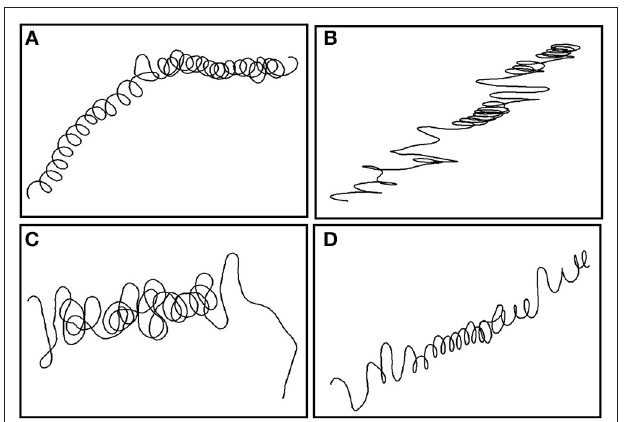
FIGURE 5 | Fifteen minute pseudo-tracks of looping behavior from each sandbar individual around dusk. (A) Shark 1 at 17:30 at depth 36m; (B) Shark 2 at 18:08 at depth 67m; (C) Shark 3 at 17:47 at depth 67m; and (D) Shark 4 at 17:42 at depth 15m.